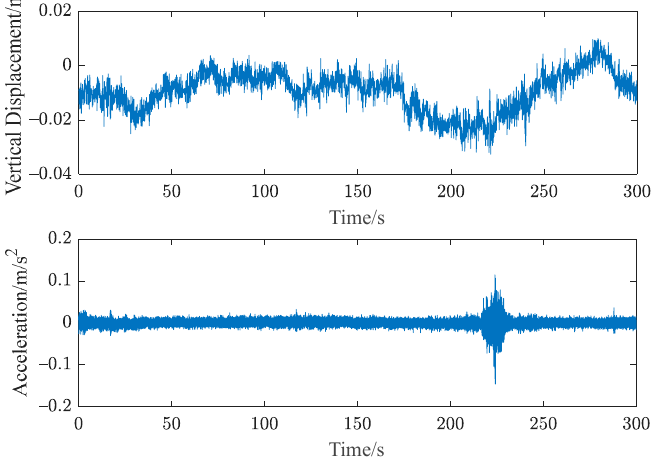
Time/s Time/s Figure 3. Suntuan River Bridge vertical GNSS displacement and Figure 3. Suntuan River Bridge vertical GNSS displacement and acceleration. Figure 3. Suntuan River Bridge vertical GNSS displacement and acceleration.